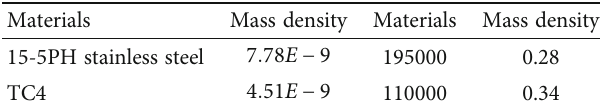
Figure 1: Geometry parameters of the shear pin and its connecting lugs. Table 1: Material properties.